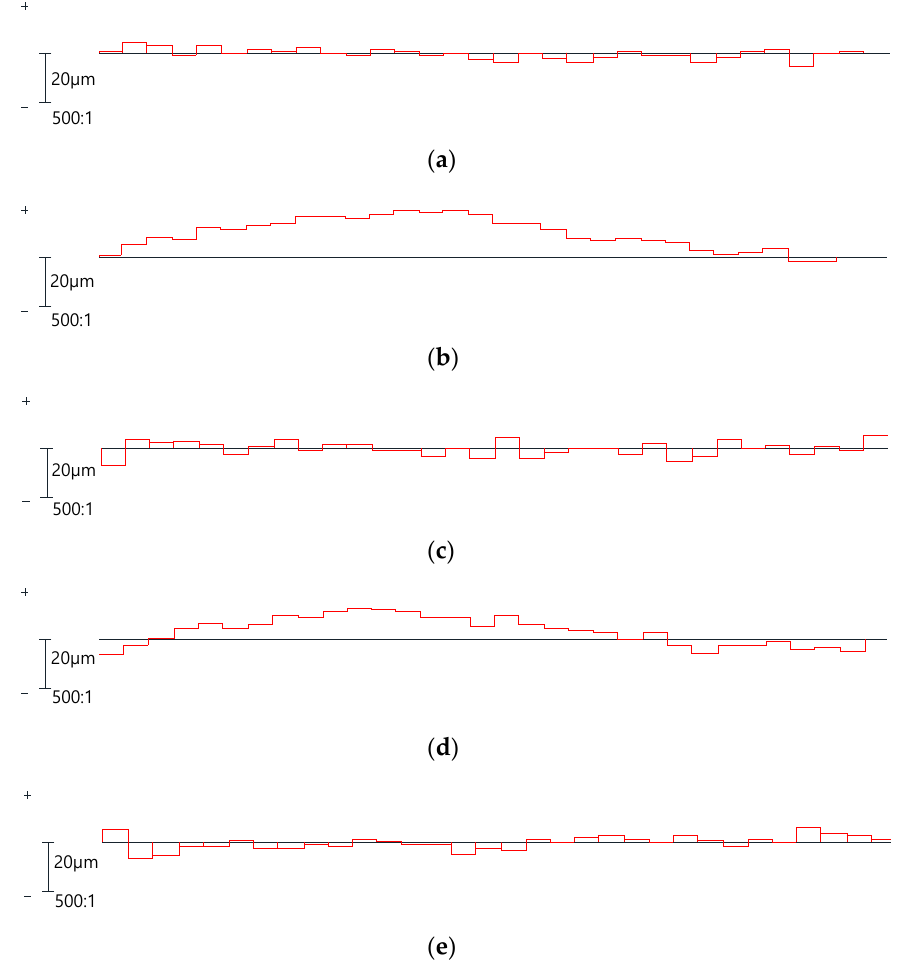
Figure 16. Gear precision measurement results: ( a ) Tooth to tooth spacing fp, left flank; ( b ) Index Fp, left flank; ( c ) Tooth to tooth spacing fp, right flank; ( d ) Index Fp, right flank and ( e ) Runout Fr. After 100,000 cycles of the durability testing of the WLF helical gear, no abnormalities were detected via visual inspection. This implies that the WLF helical gear had an accepta- ble rotational ability in the facility. In the torsional strength test, the damage occurred between the helical-shaped WLF material part and steel hub insert part at a torsional ro- tation angle of 2.5°, as shown in Figure 17. The damage strength was measured at 880.87 N ∙ m, which is the data of the maximum inflection point of the graph. When applying the WLF helical gear to the driving parts, the current results were considered as engineering data. The noise associated with the WLF helical gear showed a decrease of 5.4 dB compared to that of the existing steel helical gear. Table 7 compares the results of the performance tests between the WLF helical gear and the conventional helical gear.